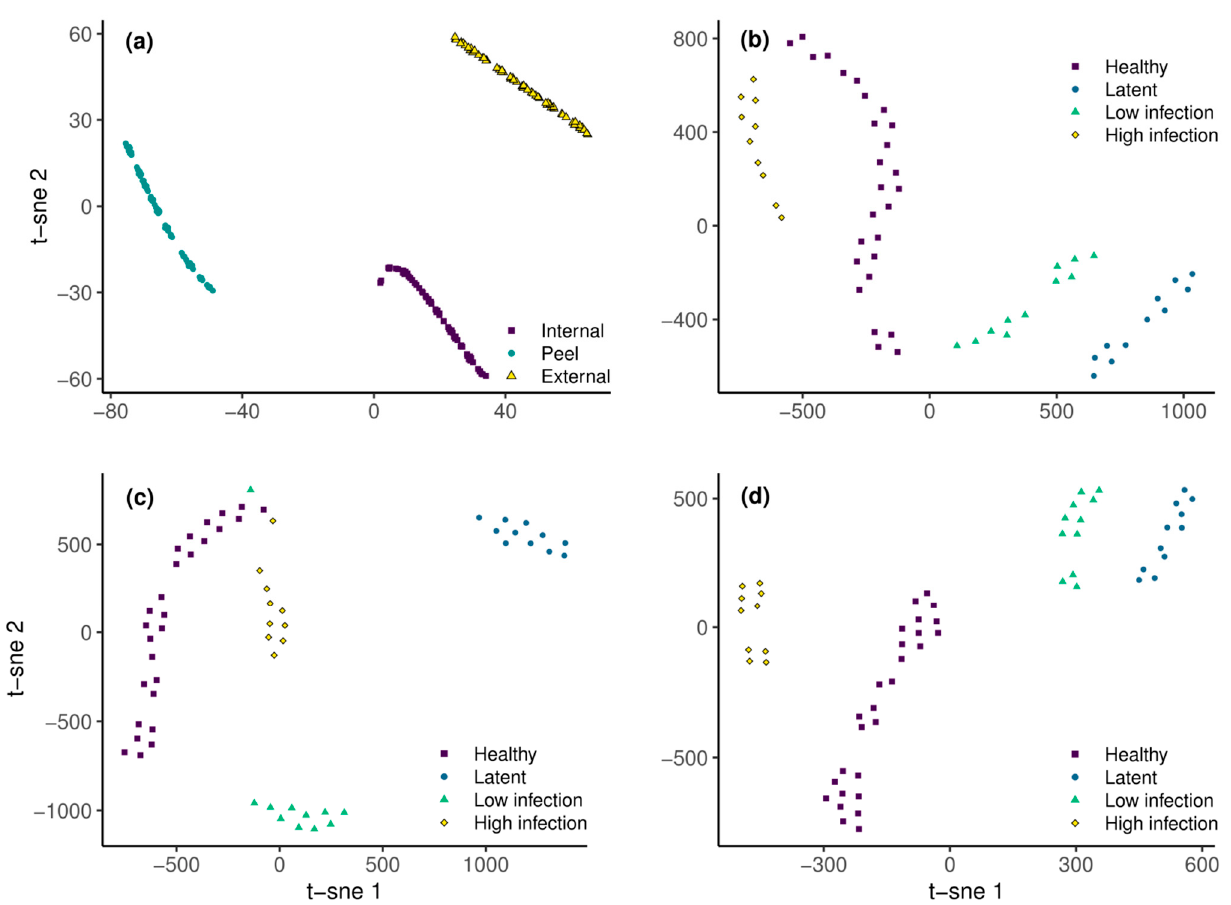
Figure 3. t-SNE scatter plots of spectral derivative data. ( a ) Tuber preparation groups; ( b ) internal data from halved tubers; ( c ) data from peels; ( d ) epidermis data.